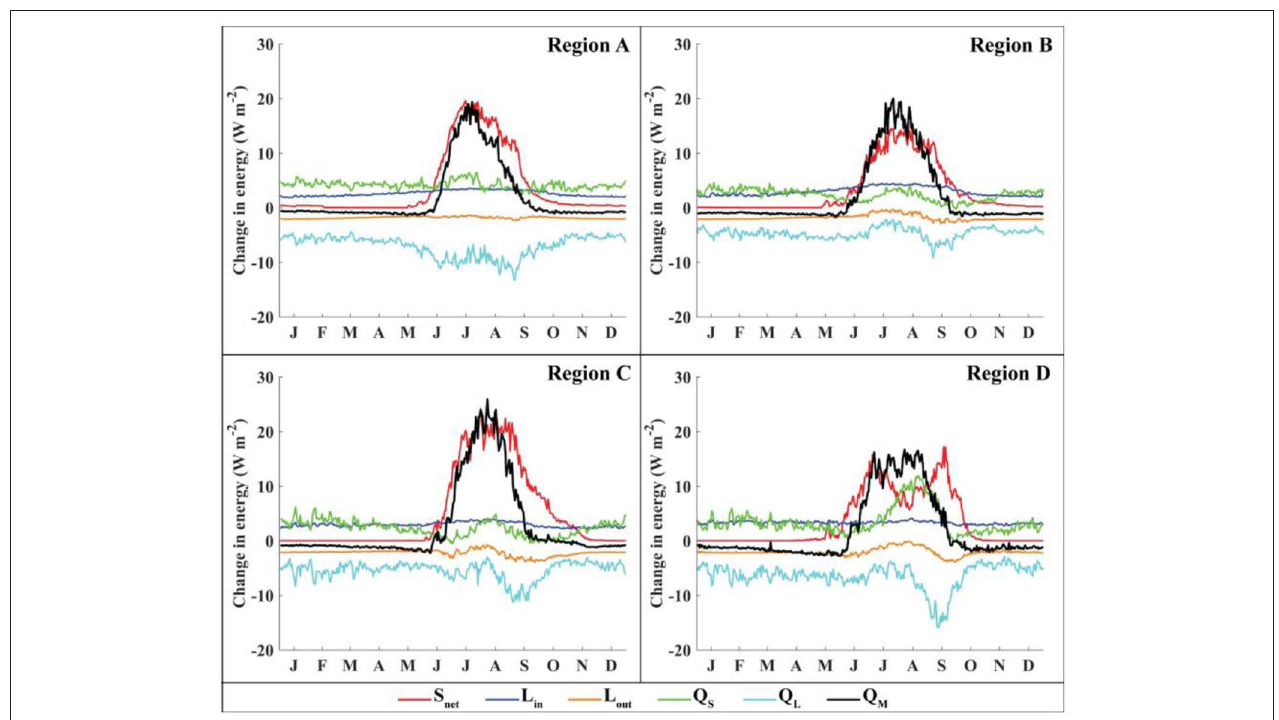
FIGURE 8 | Change in energy fluxes, for a 1 ◦ C temperature increase, averaged over the entire glacier and for each day over the 13 years covered by this study.